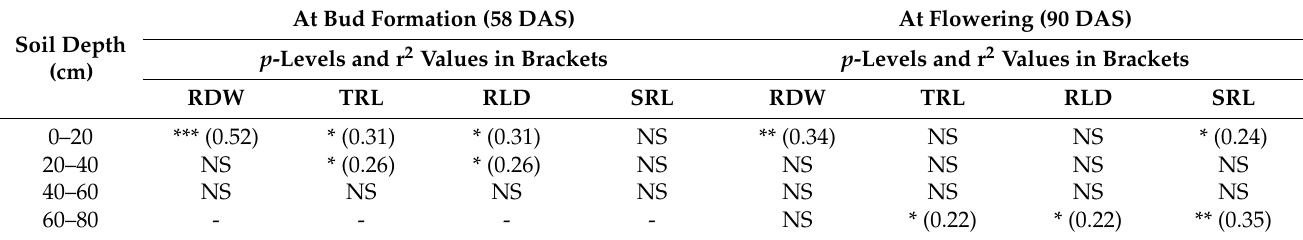
Table 4. Relationships between yield and root parameters at a 0–60 cm (at 58 DAS) and a 0–80 cm depth (at 90 DAS). Soil